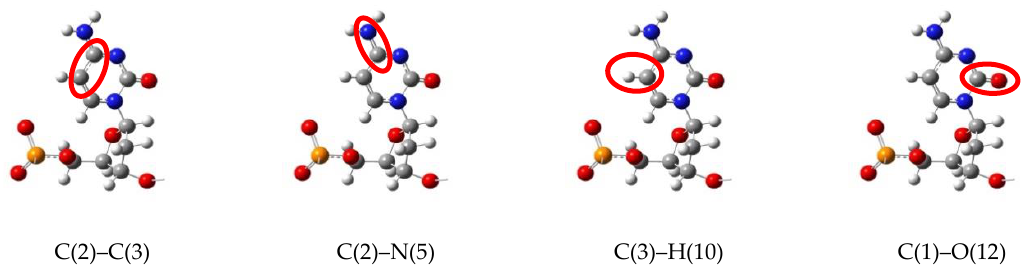
Figure 3. Bonds in cytosine nucleotide (cytidine) for which vibrational spectra are shown below. Numbers of atoms are in internal numbering order.